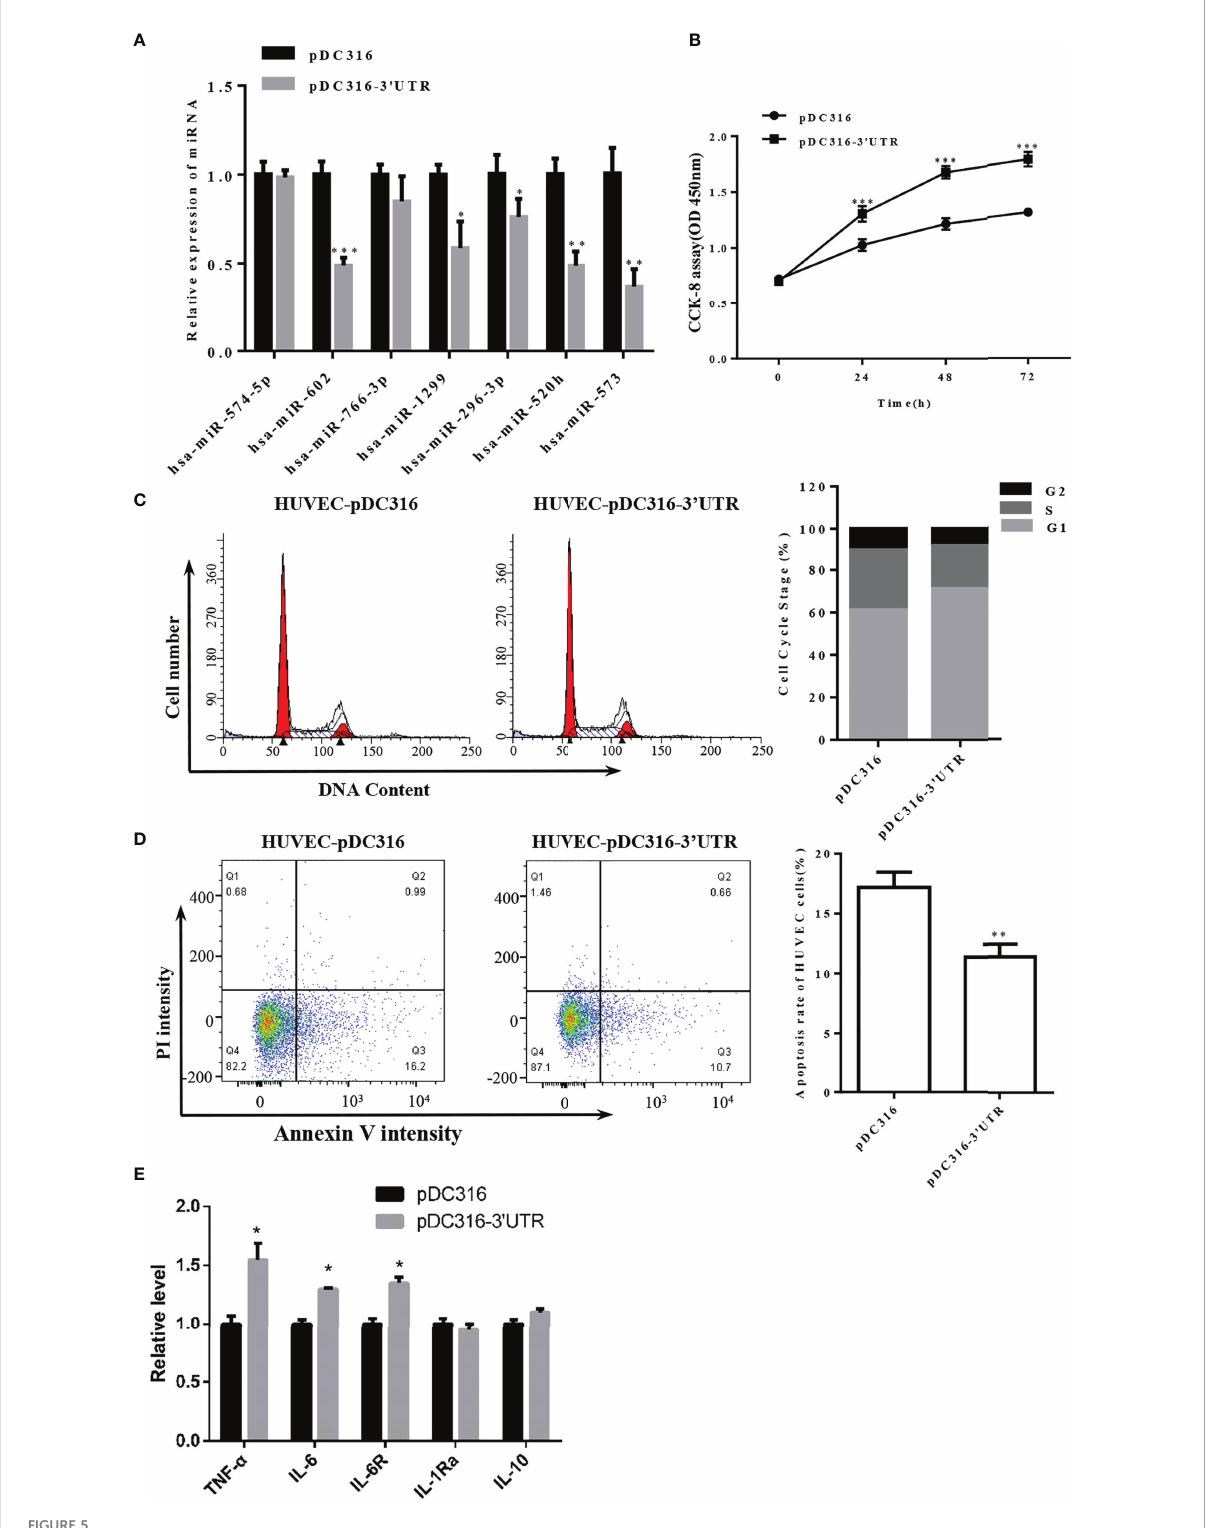
FIGURE 5 Overexpression of S-3 ′ UTR downregulated miR-296 and disturbed 293T cell growth. (A) Expression levels of miRNAs following overexpression of S-3 ′ UTR in HUVECs. Note that miR-602 was the most signi fi cant. (B) Overexpression of S-3 ′ UTR enhanced HUVEC proliferation. (C) Overexpression of S-3 ′ UTR increased the proportion HUVECs in G1 phase. (D) HUVEC apoptotic rate was reduced by overexpression of S-3 ′ UTR. (E) Level of IL-6, IL-6R and TNF- a was increased following overexpression of S-3 ′ UTR. (*p<0.05,